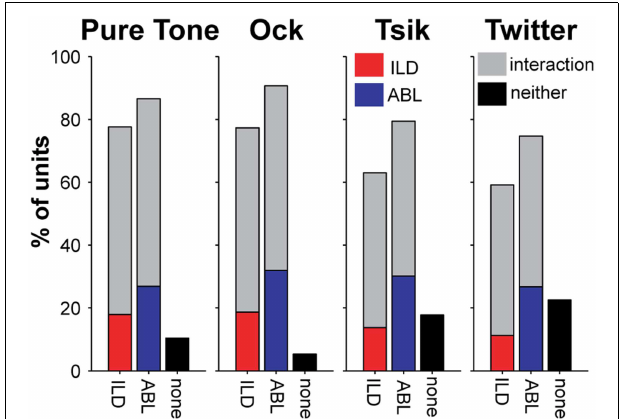
FIGURE 4 | Percentage of cells sensitive to ILD and ABL for each stimulus type. The total percentages of cells sensitive to ILD and to ABL (including interaction effect) for each stimulus are shown in the four sub-plots. The color code indicates whether cells are sensitive to only one variable, or have a significant interaction effect. Cells are considered to be sensitive to ILD if there is a significant main effect for ILD and/or a significant interaction of ILD and ABL (Two-Way ANOVA, p < 0 . 01 ). The corresponding rule applies to ABL. These categories are not mutually exclusive, i.e., a cell can be sensitive to both ILD and ABL and therefore would contribute to both bars; however, each cell can only contribute to a single bar only once, i.e., cells with interaction effects will appear in gray regardless of main effect(s).